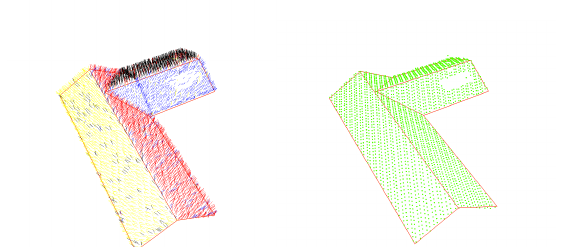
Figure 4. Intersection lines per color-coded class (left), overlay of the surfaces with the laser points (right) Figure 5. DOP with building ground plans (left) and After the reduction of the classes an arithmetic mean is corresponding laser point cloud of a building in yellow which calculated for all surface normals of each class. By means of needs to be edited (right) mathematical methods of the descriptive geometry the intersections of the surface normals are calculated. The ridge The degree of automatic roof recognition can be expressed by lines are calculated from intersections between the saddle roofs. editing rate is only 15 %. The higher the percentage of historical surface normals. The result is an automatically derived vector buildings, the lesser the automatic recognition rate of the model, consisting of four areas. Figure 4 shows the classified and color-coded surface normals (left) respectively the plot of laser points (right) placed over the vector model.